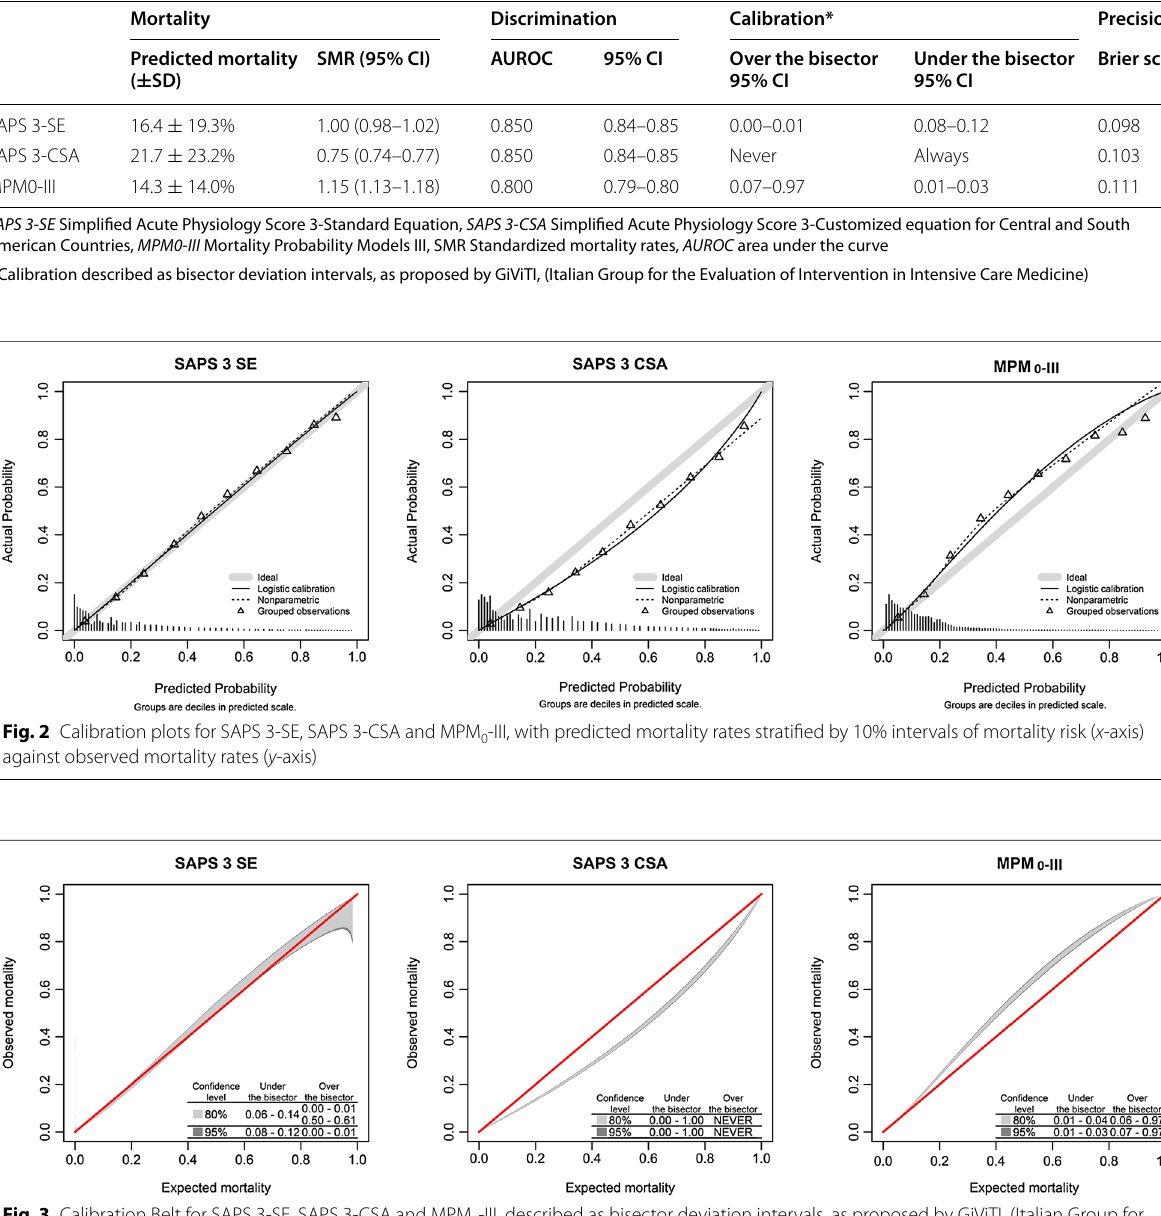
Fig. 3 Calibration Belt for SAPS 3-SE, SAPS 3-CSA and MPM 0 -III, described as bisector deviation intervals, as proposed by GiViTI, (Italian Group for the Evaluation of Intervention in Intensive Care Medicine). The times the calibration belt significantly deviates from the bisector using 80 and 95% confidence levels are described in the lower right part of the